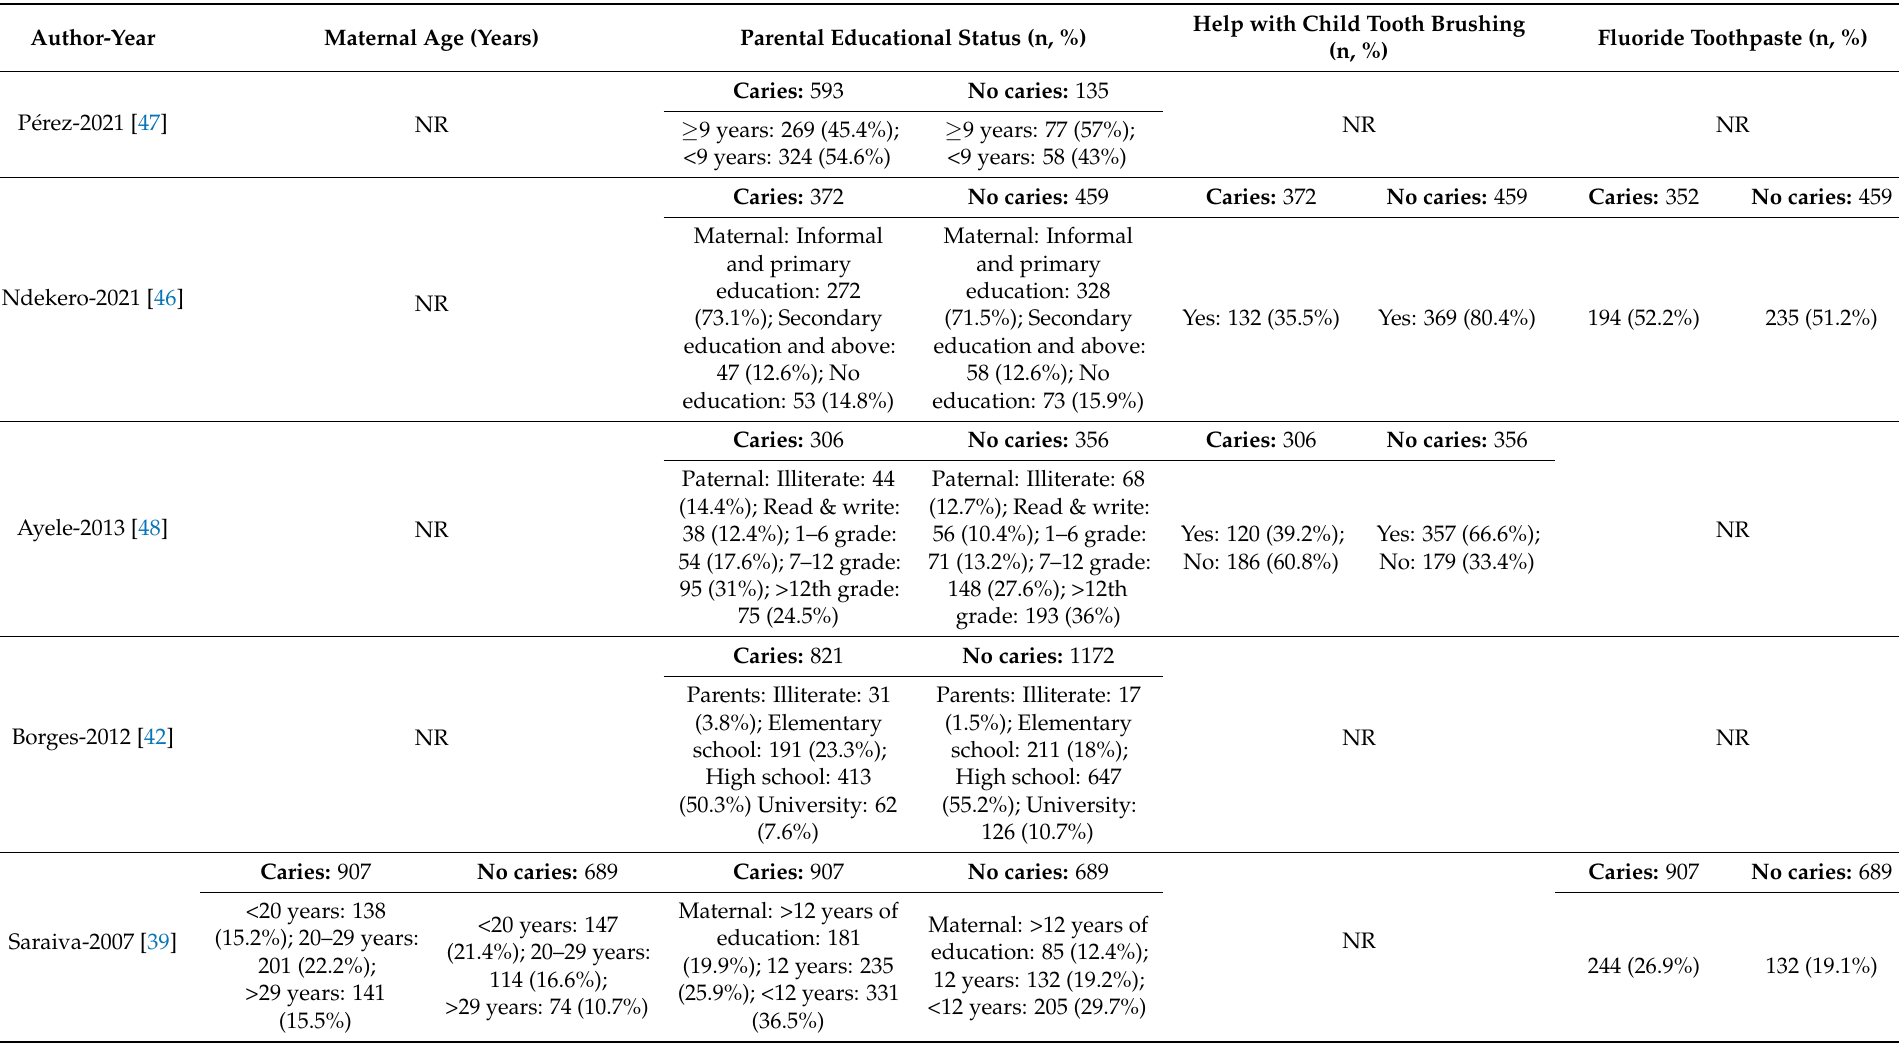
Table 3. Family-level characteristics of eight